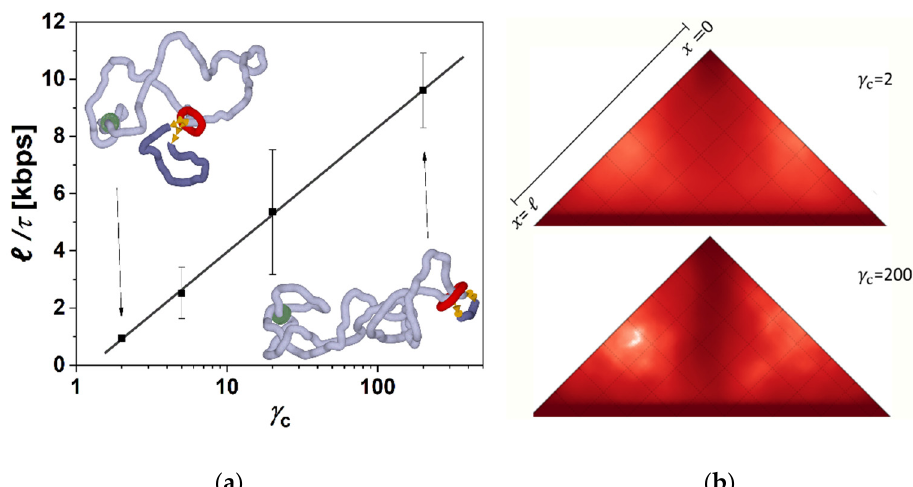
Figure 3. The higher friction between cohesin ring and fiber induces higher levels of supercoiling and extrudes loops at higher rates. ( a ) Loop extrusion rate for different settings of γ c imposing friction between cohesin ring and chromatin fiber, resulting in different levels of accumulated supercoiling. The loop extrusion is shown as a function of imposed friction between cohesin and fibers. The insets show snapshots from the end of the simulations at the lowest and highest settings of the friction. ( b ) The contact maps are calculated during the loop extrusion. The contact maps were calculated along the trajectories as the average over 10 simulation runs. The maps show the loss of ant-diagonal when the loop extrusion is more stochastic, i.e., random, when lower settings of friction between cohesin ring and chromatin fiber allow the fiber to sample larger conformational space. The data acquisition for the contact maps calculation stopped once the ring slipped away from the chromatin fiber. Biologically, the rings should stay stuck to CTCF’s proteins at borders of the domain [56], which would emphasize the loss of the anti-diagonal in simulations with lower friction.